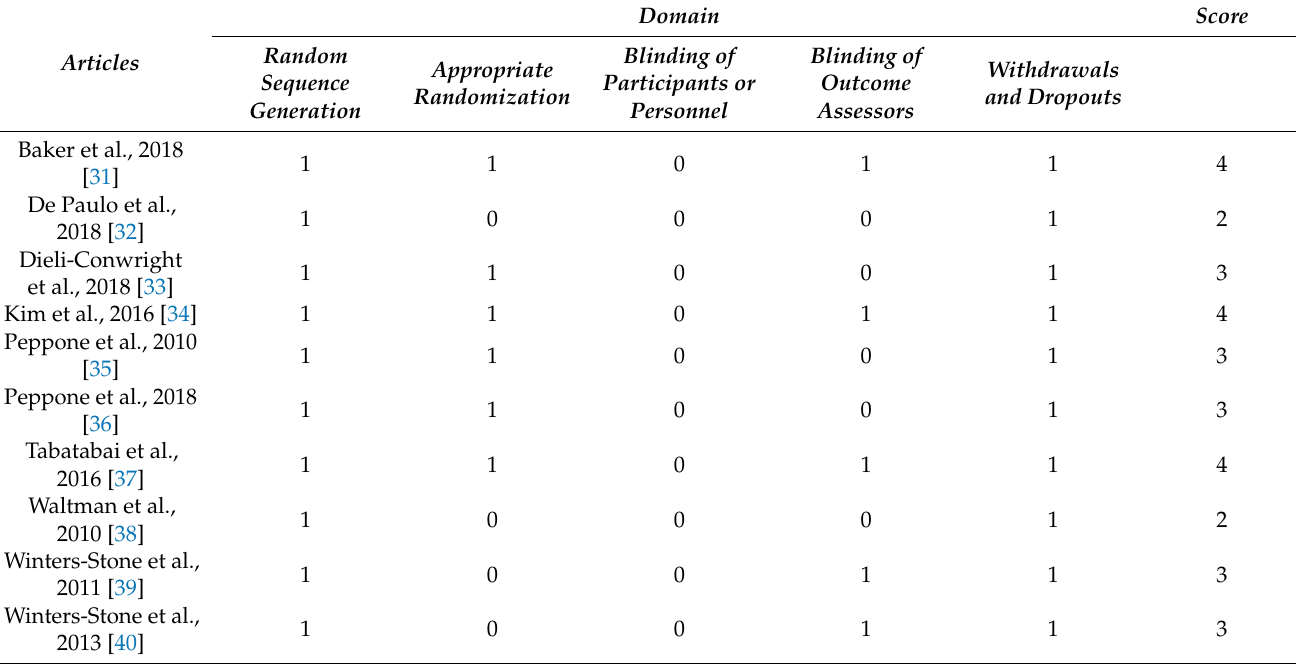
Table 5. Quality assessment of the studies included in the present systematic